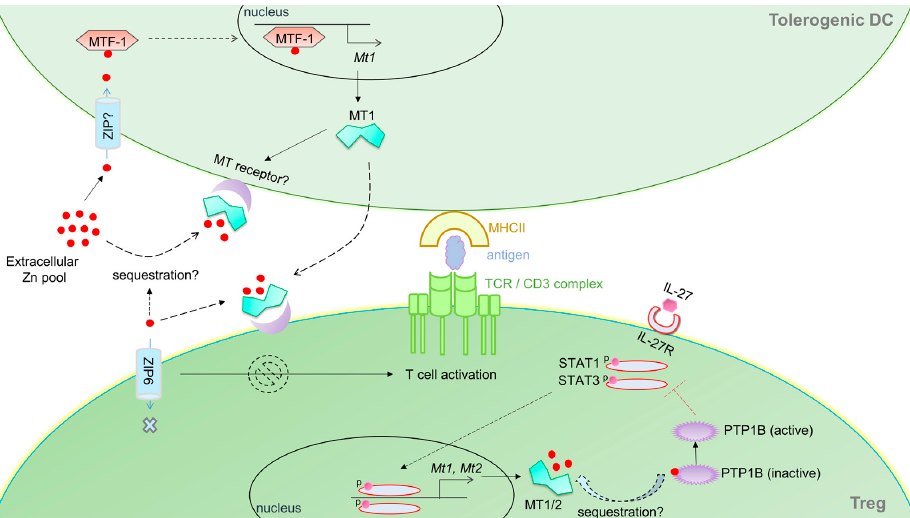
Figure 3. MT-Zn axis in tolerogenic DC–Treg interactions. DCs exposed to a pool of extracellular Zn develop a tolerogenic phenotype. Zn imported into DCs triggers MT-1 expression, possibly in an MTF-1 dependent manner. MT1 is expressed on the membrane of tolerogenic DCs and may also be actively secreted and bind to the T cell membrane. Upon activation, T cells import Zn via ZIP6 that mobilizes to the DC-T cell synapse. Zn sequestration by extracellular MTs may hinder this process, potentially stalling T cell activation. However, MT expression within T cells suppresses Treg development. IL-27 induces Tregs (in this case, IL-10 producing Tr1 cells) via STAT1 and STAT3 signaling. These STATs induce MT1 and MT2 that negatively feedback to inhibit STAT activation. MTs plausibly sequester Zn from PTP1B, an enzyme that is inhibited by Zn. Active PTP1B mediates dephosphorylation of STAT1 and STAT3 ultimately attenuating Treg development. Red dots, Zn ions; all solid lines and arrows are known links; all dotted lines and arrows are predicted links; red T bar depicts inhibition of STAT1/3 by PTP1B (active).